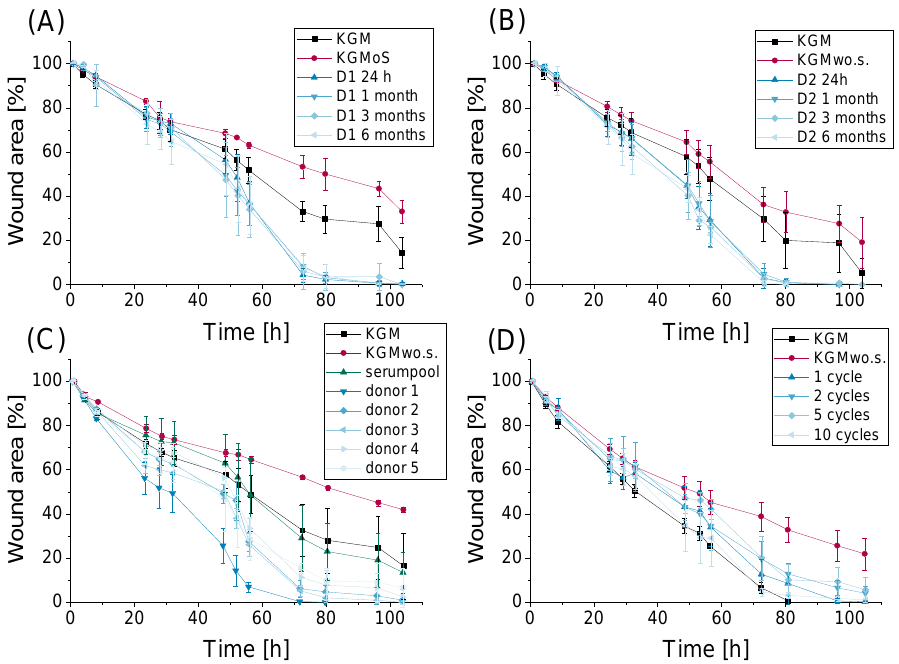
Figure 4. ( A , B ) Stability assay of 2.5% serum from donors 1 and 2 (D1, D2) after storage at − 20 °C for 24 h, 1 month, 3 months and 6 months; 3 wells per sample were analyzed (n well = 3); 6 pictures of the wound area were taken per well (n picture = 6), mean ± SD; ( C ) donor variability of serum 1% (n Well = 4, n picture = 6, mean ± SD); ( D ) i nfluence of freeze‒thaw cycled serum 2.5% on wound closure of HCE-T cells in KGMwo.s. medium (n well = 3 – 4, n picture = 6, mean ± SD).